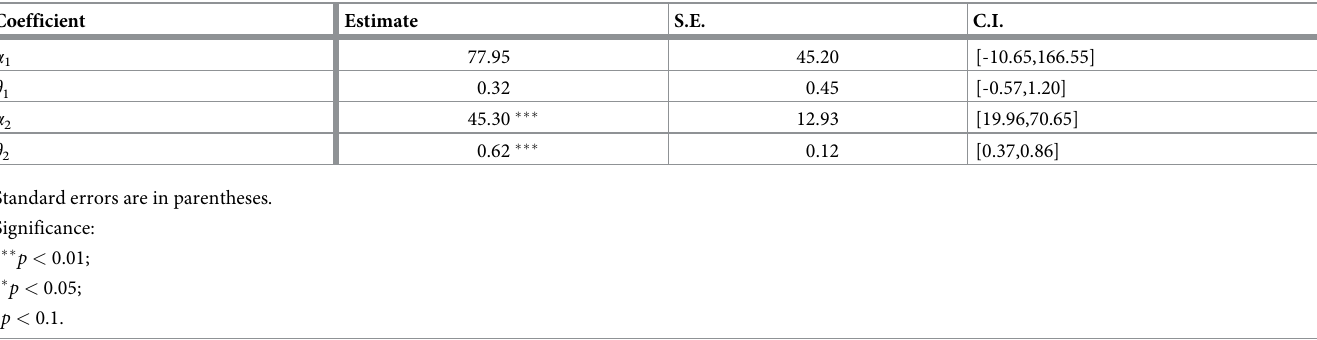
Table 5. Least squares estimates of 2-regime threshold model that we build with CPI and GDP